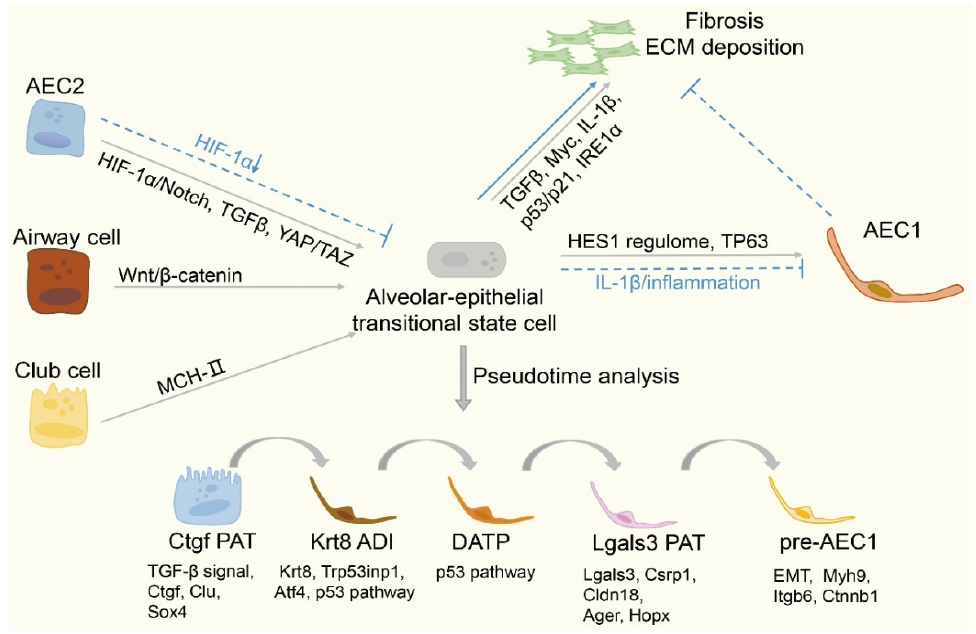
Figure 1. The differentiation trajectory of the transitional state cell and model of alveolar regen- eration. The transitional state cell can arise from AEC2, airway, and club cells. In this model, the progenitors obtain the highly upregulated TGF- β , Sox4 , Krt8 , etc., lose their identity markers, and morphologically shift from cuboid to squamous. These cells display cellular senescence-like profiles. Finally, transitional state cells can permanently remain in the transitional state to exacerbate the severity of fibrosis or to complete their proliferation and differentiation to AEC1. The transitional state cells exist in the human and mouse pulmonary model. They serve as checkpoints to control the process of fibrosis.